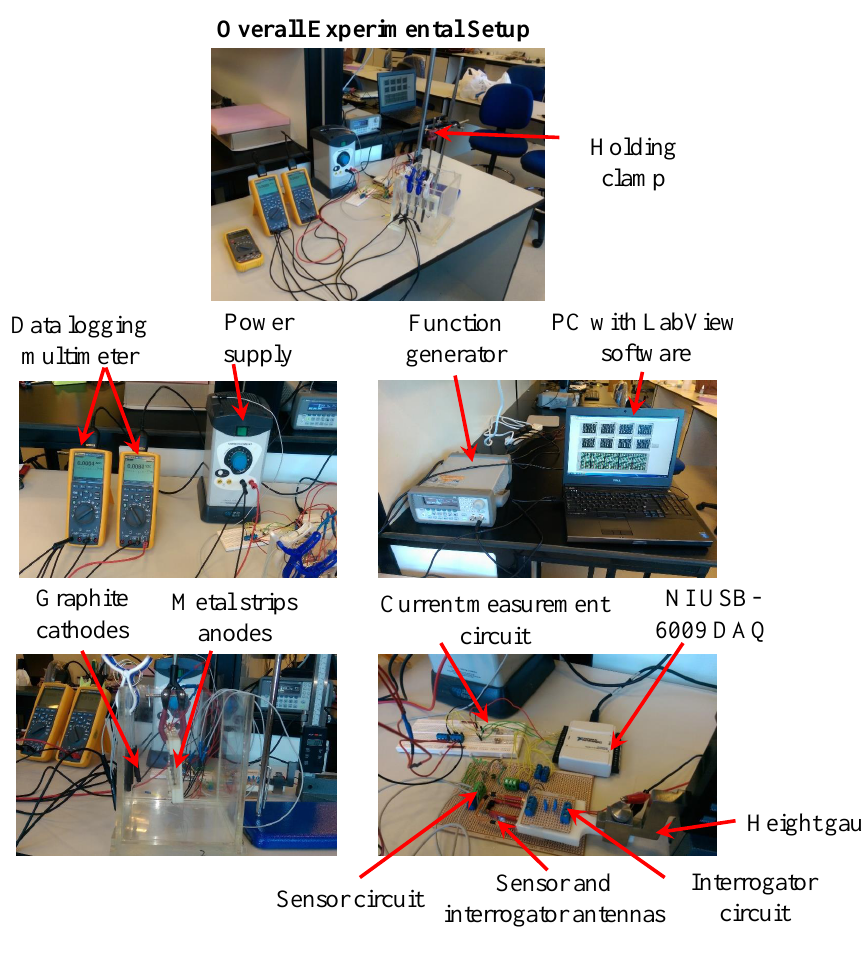
Figure 10. Corrosion test experimental